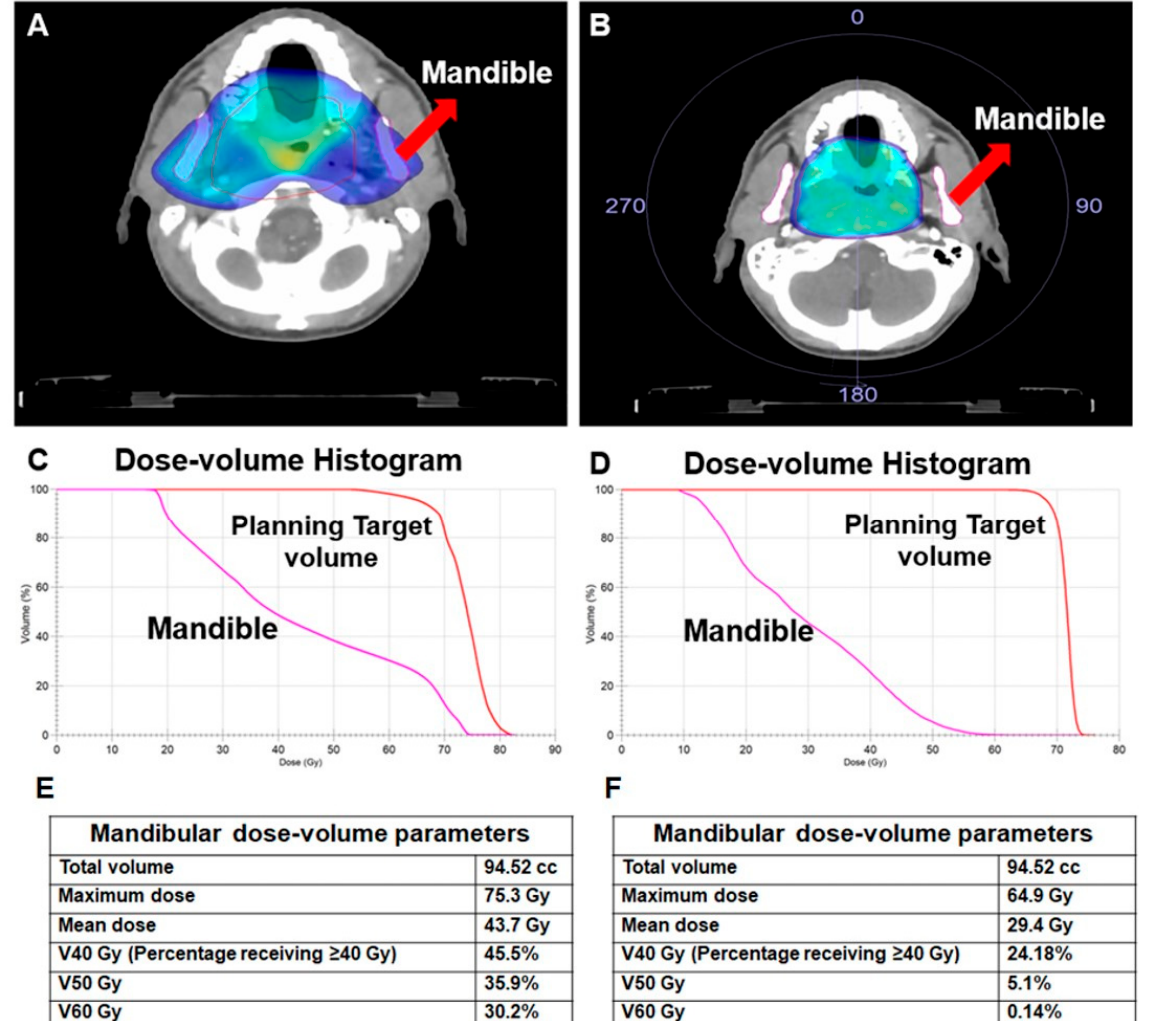
Figure 2. A comparison of two different treatment plans for the same patient with nasopharyngeal carcinoma illustrates the effect of the radiotherapy technique on the doses received by the mandible. ( A ) 3-dimensional conformal radiotherapy (3D-CRT), ( B ) Volume-modulated arc therapy (VMAT), ( C ) Dose-volume histogram for 3D-CRT, ( D ) Dose-volume histogram for VMAT, ( E ) Dosimetric measures for 3D-CRT, ( F ) Dosimetric measures for